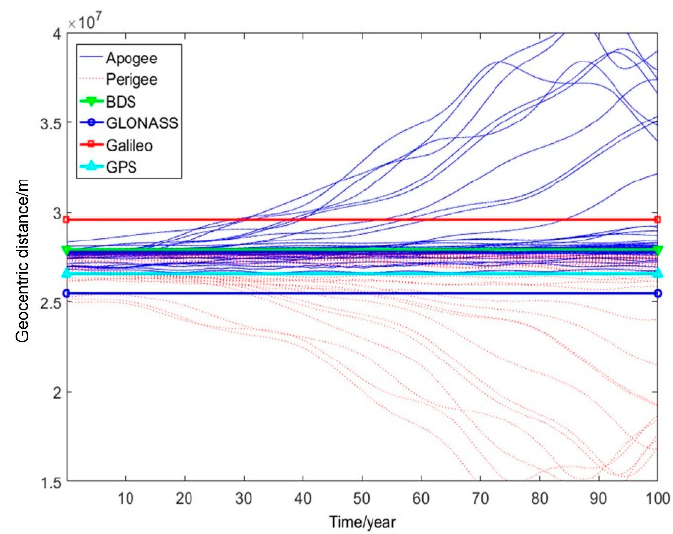
Figure 8. Orbital variations of GPS disposed satellites over 100 years.